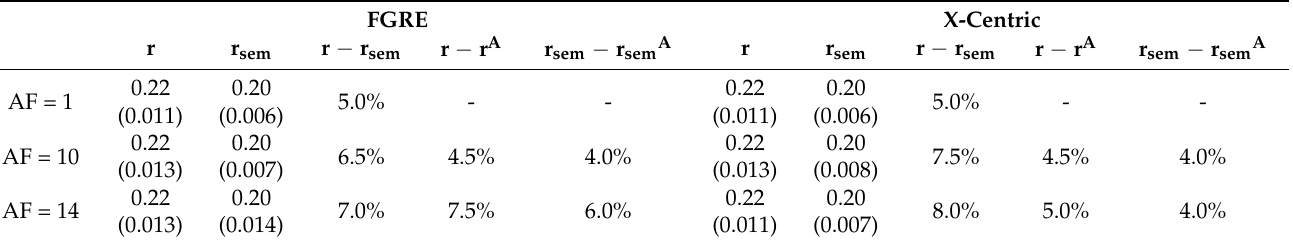
Table 1. 3 He MRI-based Fractional-Ventilation Measurements (average from all rats).